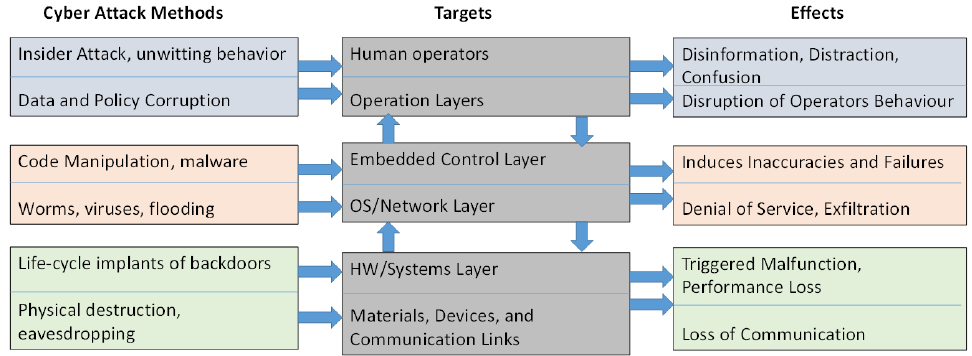
Figure 1. Potential cyber-attack methods, targets and